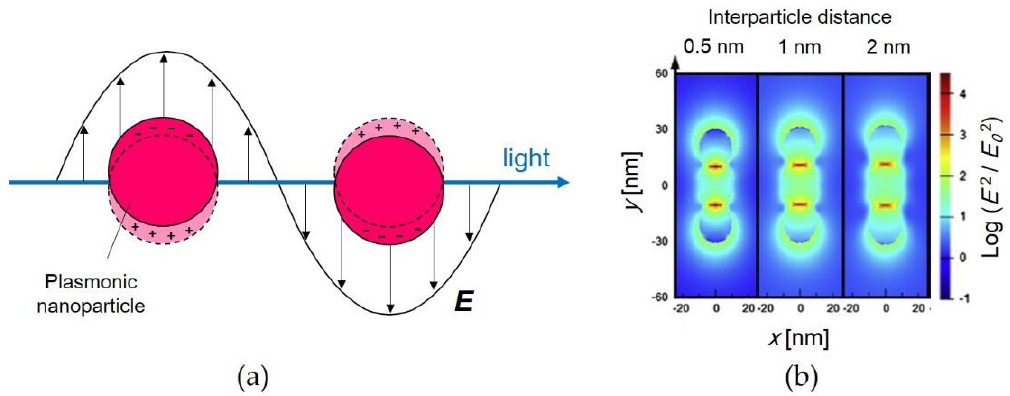
Figure 1. ( a ) Scheme of localized surface plasmon resonance (LSPR) of plasmonic nanoparticles (NPs); and ( b ) mappings of electric field intensities between gold (Au) NPs for different interparticle distances: 0.5, 1, and 2 nm. Reproduced with permission from Reference [16] (Copyright 2014 Elsevier).